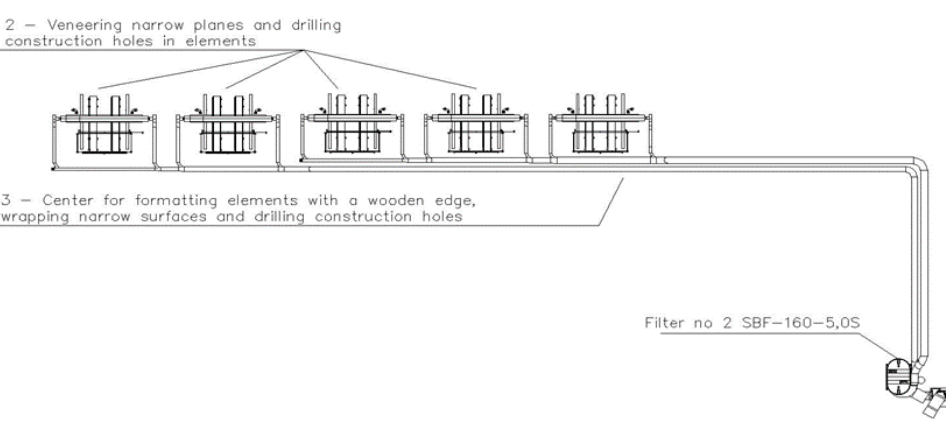
Figure 2. Line diagram of machining centers.